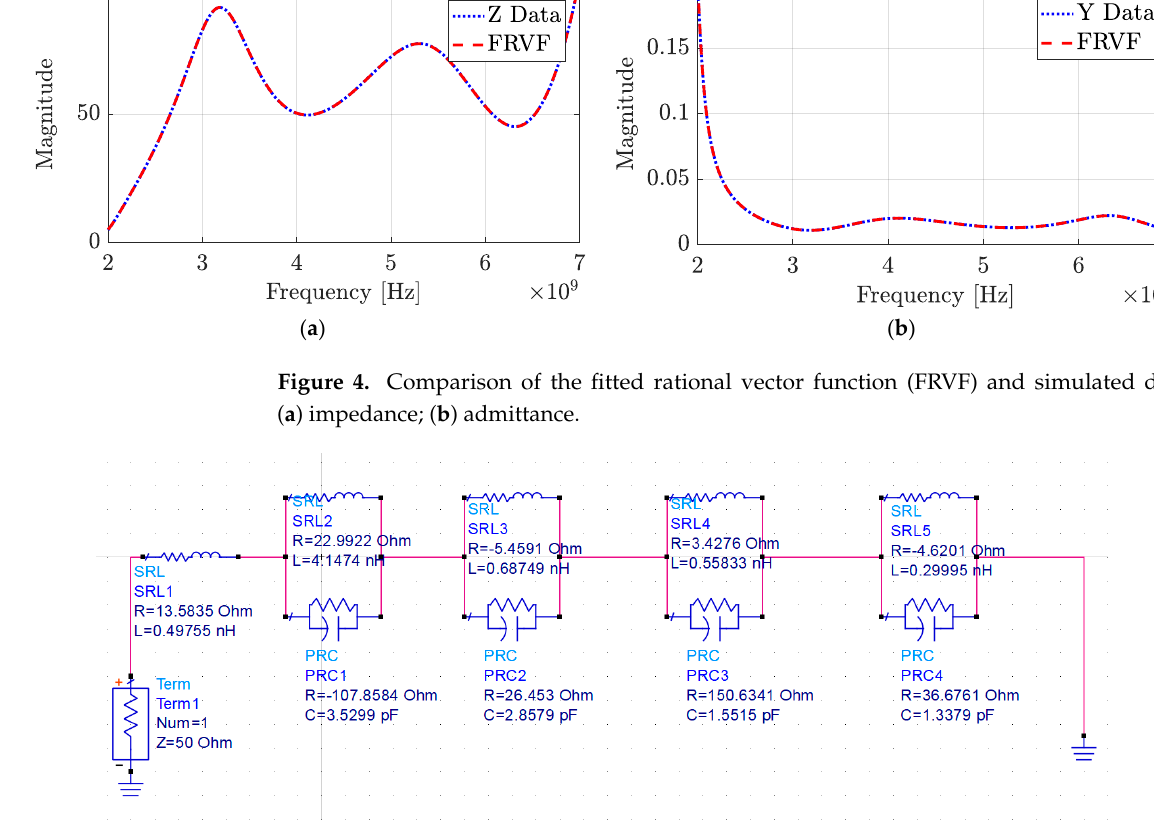
Figure 5. ADS model of the lumped equivalent circuit based on Z data.